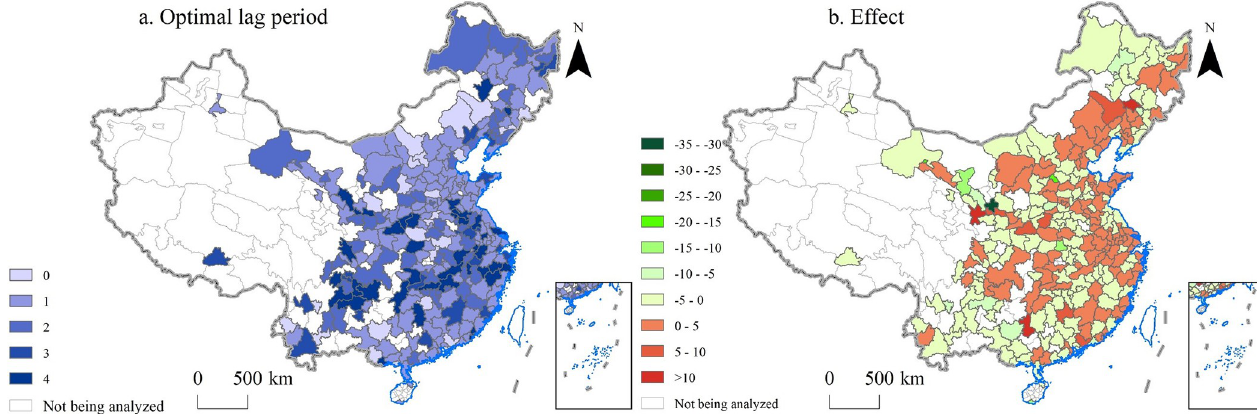
Fig 8. The optimal lag period and effect of average export similarity index (AESI) on market competitive index (MCI). The optimal lag period is the lag period with the minimum mean standard error. Meaning of effect: If AESI is increased by one unit, MCI will increase/decrease by the corresponding amount. MCI’s increases are expressed as positive values and decreases as negative